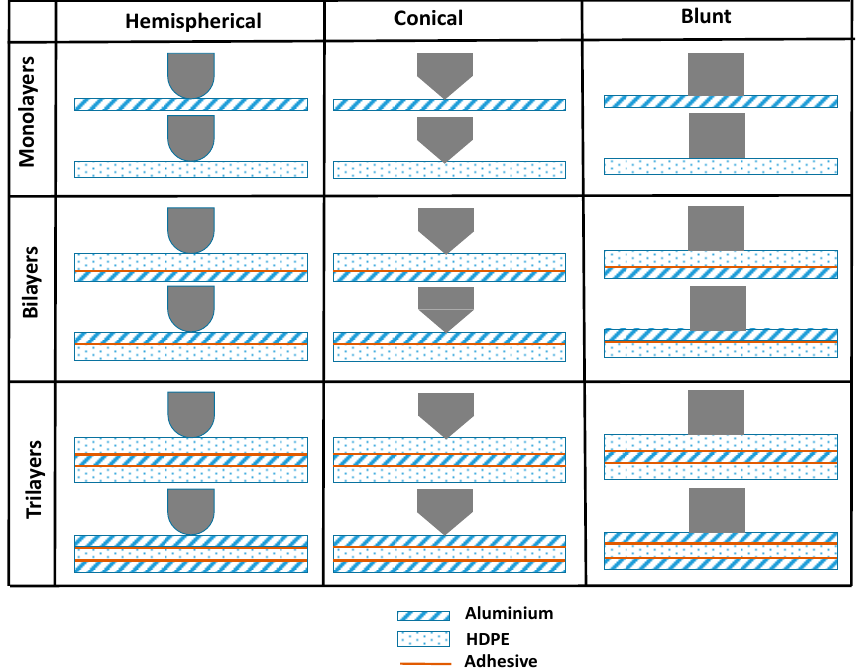
Figure 1. Schematics of the indenter and laminate configurations used in quasi-static perforation tests.